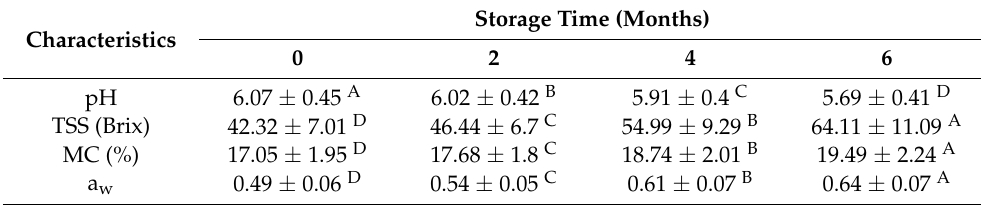
Table 2. Comparison of the mean values ± standard deviation of the pH, total soluble solids (TSS), moisture content (MC), and water activity (a w ) of the stored date fruits under different cold storage times.